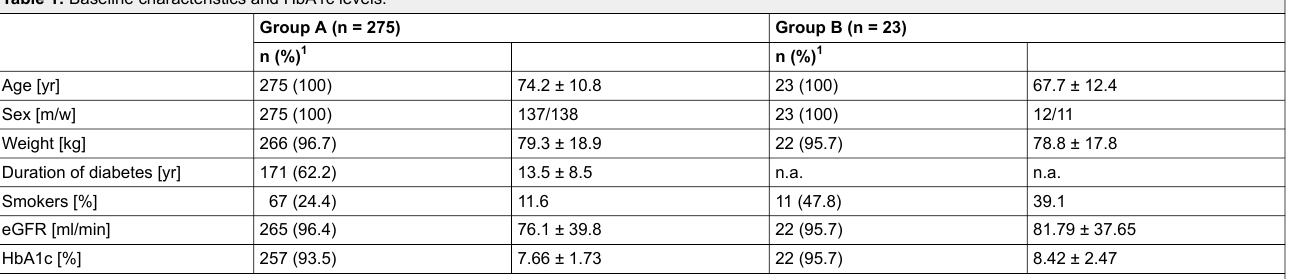
Table 1: Baseline characteristics and HbA1c